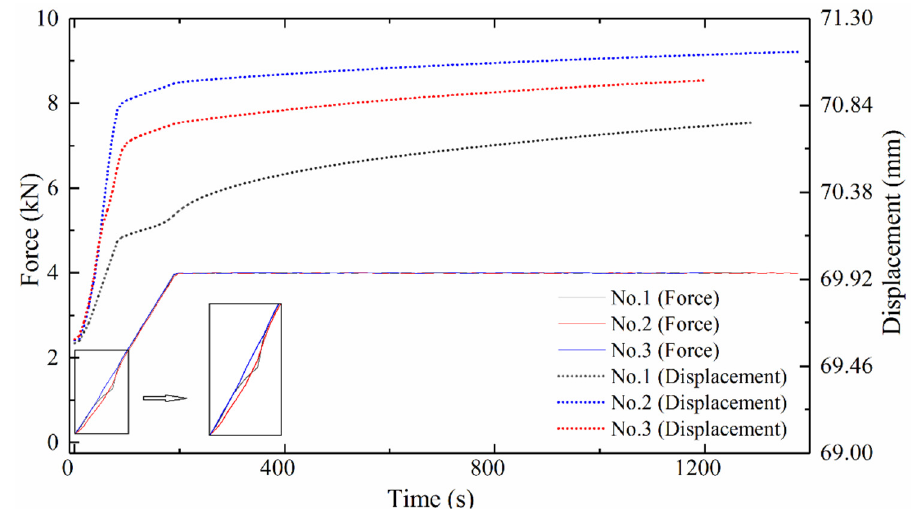
Figure 4. The waveforms of the force and displacement of the lower mold. The deformation of the glass preform is related to the relative position of the upper and lower molds. The upper mold was installed on the fixed upper axis of the molding system, while the lower molds were installed on the mobile lower axis. Therefore, there is a need to describe the displacement of the lower axis with time. The displacement data are processed with regression analysis with IBM SPSS Statistics software (25, SPSS Inc., Chicago, IL, USA). When the time is t , the displacement is y i for the i th experiment. Based on the results, the line types of the curve consists of linear, conic, and cubic curves. The three kinds of curves are expressed as Equations (3)–(5).